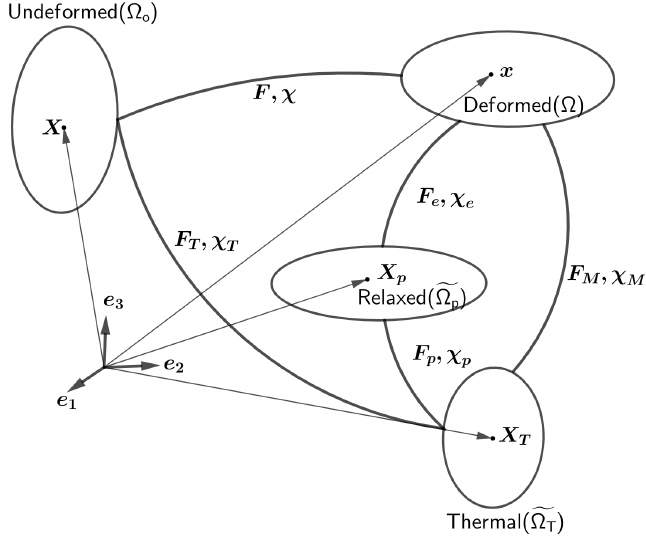
Figure 1. An analogous decomposition scheme for the deformation